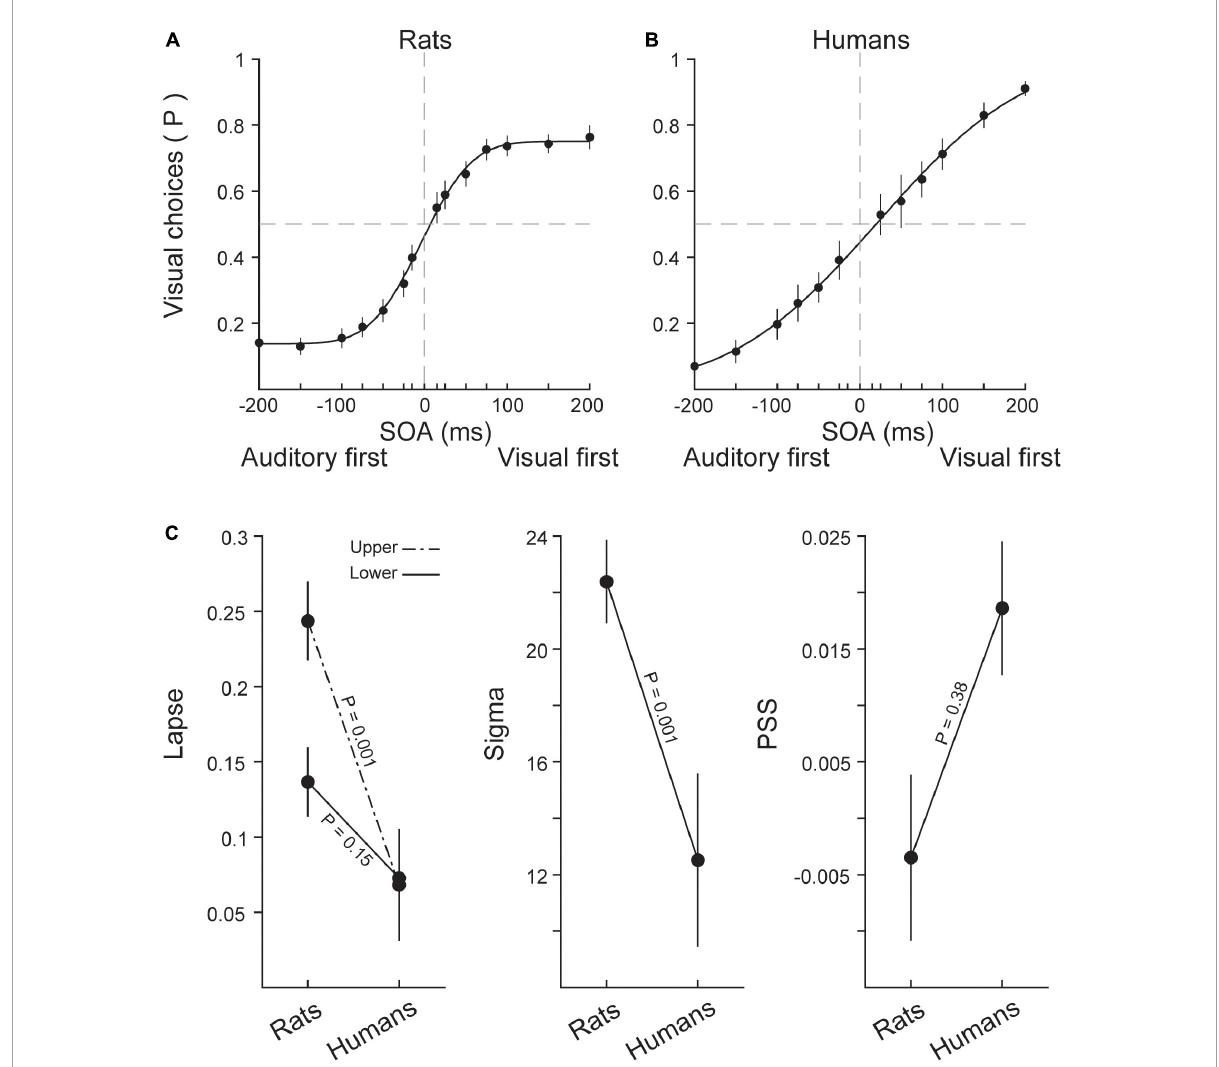
FIGURE2 Psychophysical quantification of performances in rats and humans. (A) The averaged responses to bimodal stimuli in different SOAs in rats. Positive SOAs represent trials in which the visual stimulus was presented first. Negative SOAs represent trials in which the auditory stimulus was presented first. Black circles indicate the average responses across eight rats, and the black line shows the sigmoidal fit (cumulative Gaussian function) to performance values. The mean of the sigmoidal fit represents the point of subjective simultaneity (PSS) and the sigma represents the temporal sensitivity (slope of the sigmoidal function). (B) The average performance across human subjects ( n = 10) and the fitted sigmoid. Color conventions are the same as (A) . (C) The average values of upper (visual) and lower (auditory) lapse rates, slope (temporal sensitivity) and PSS plotted for rats and humans. Error bars indicate ± SEM across